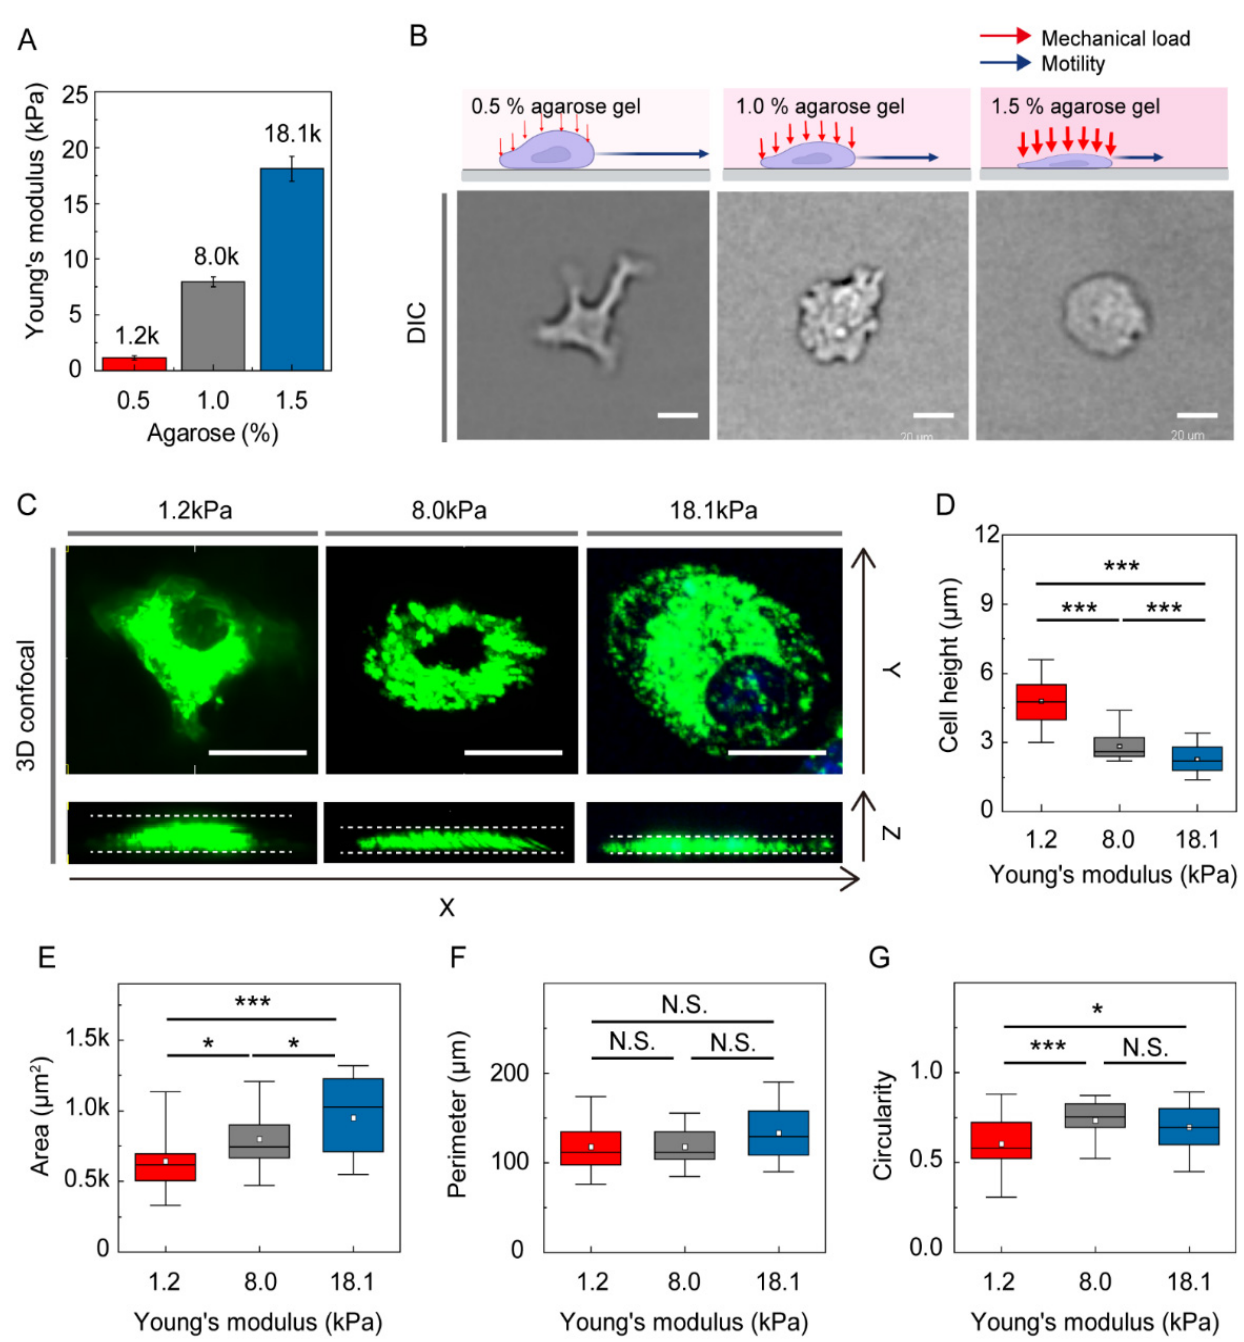
Figure 1. DC morphology is modulated by mechanical stress exerted by surrounding gels. ( A ) The Young’s modulus of agarose gel. Bars indicate mean value and error bar represent standard deviation (S.D.) ( B ) Schematic figure of DCs under agarose gels with different stiffness. The DIC brightfield images of DCs confined under different level of mechanical loads show distinctively different cellular morphology. Scale bar = 20 µm. ( C ) Morphological changes of DCs under compressive force were imaged by 3D confocal microscope images. Scale bar =20 µm. ( D ) Cell height, ( E ) cell area, ( F ) perimeter, and ( G ) circularity of DCs adapted under different level of mechanical loads given by the surrounding agarose gels were characterized. In figure D – G , Kruskal–Wallis/Dunn’s multiple comparisons test was used for comparisons of different sample populations; N.S.: p > 0.05; *: p < 0.05; ***: p < 0.001. In the box plots, the bars include 95% of the data, the box contains 75% of the data, the center bar corresponds to the median and the square point represent the mean. Data were pooled from three independent biological replicates. 1.2 kPa: n = 111; 8.0 kPa: n = 93; 18.1 kPa: n =